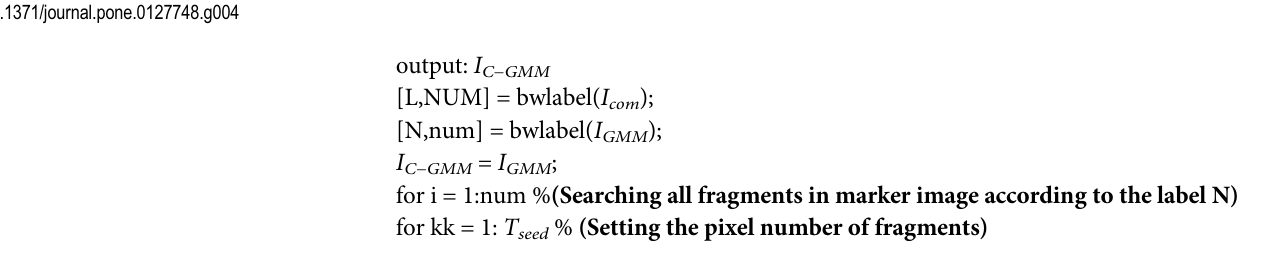
Fig 4. Vessel complementation results: (a) the fused result I gv , (b) I c the result of the gray-voting processing on I gv , and (c) I com is the binary image of the complementary image I c